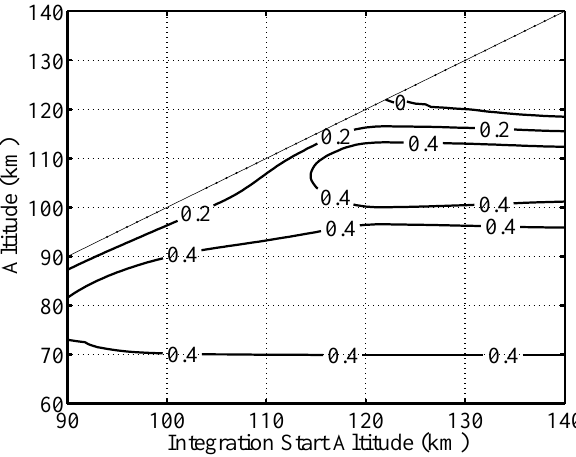
Fig. 7. Mid latitude – measurements made during disturbed solar activity and processed assuming moderate solar activity, except that the temperatures used to seed the retrieval are for disturbed solar